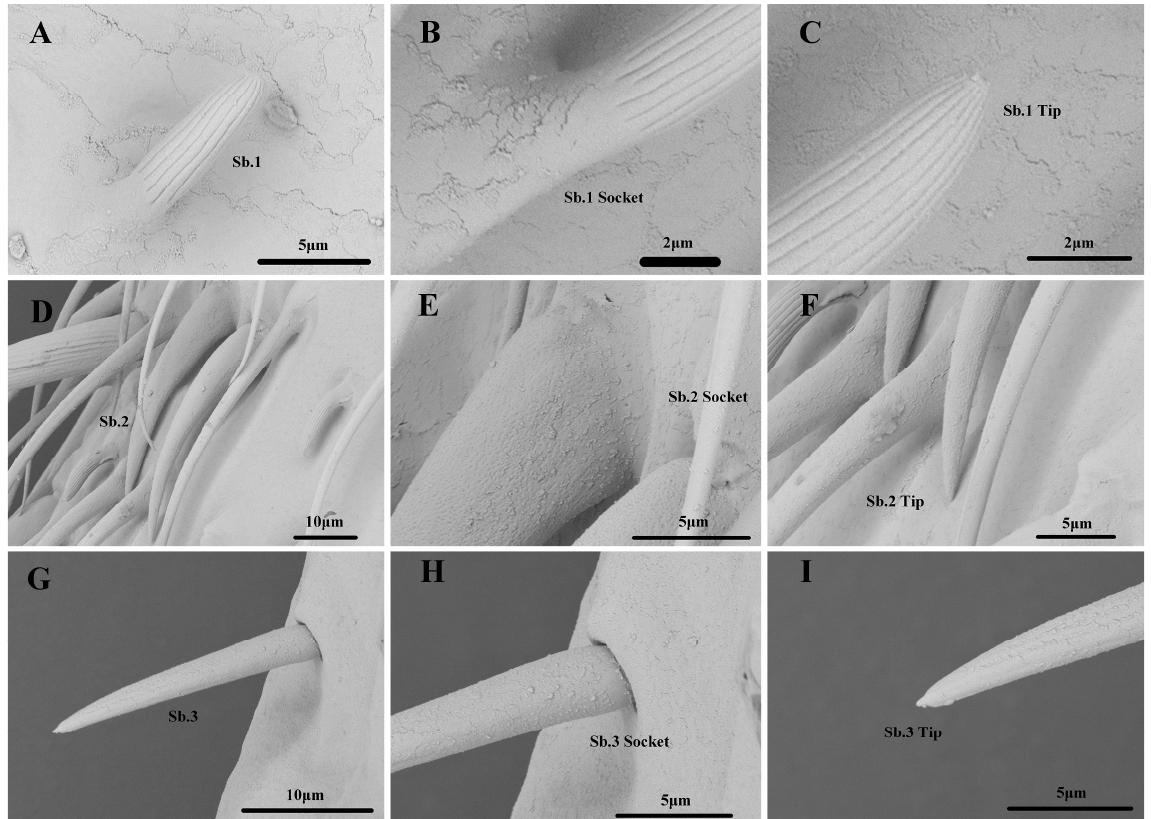
Figure 6. ( A – I ). Sensilla Basiconica of N. meleagris